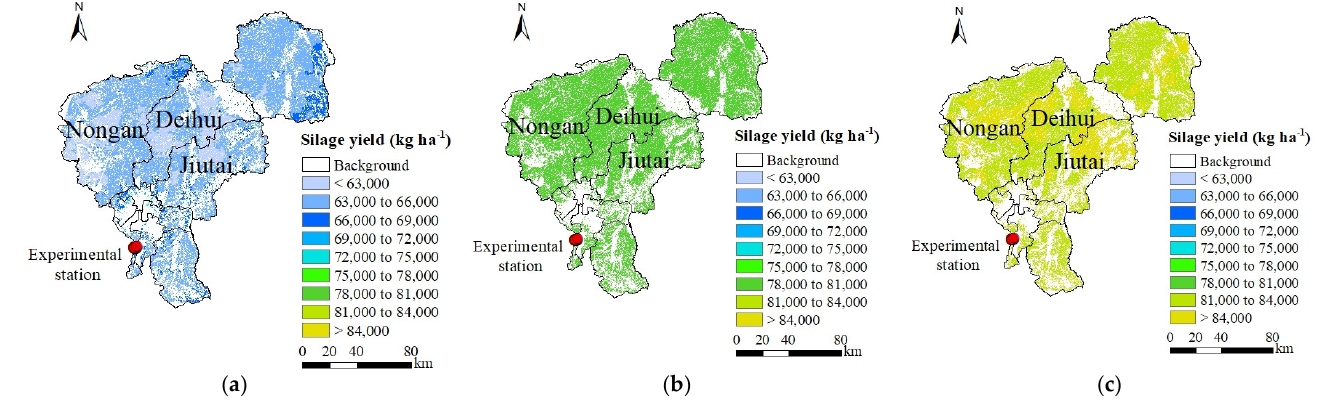
Figure 16. Predicting silage yield values using the NR-logistic model calibrated in 2019 based on the field observations in three different days: ( a ) 2017/7/16; ( b ) 2017/8/10; ( c ) 2017/8/31.